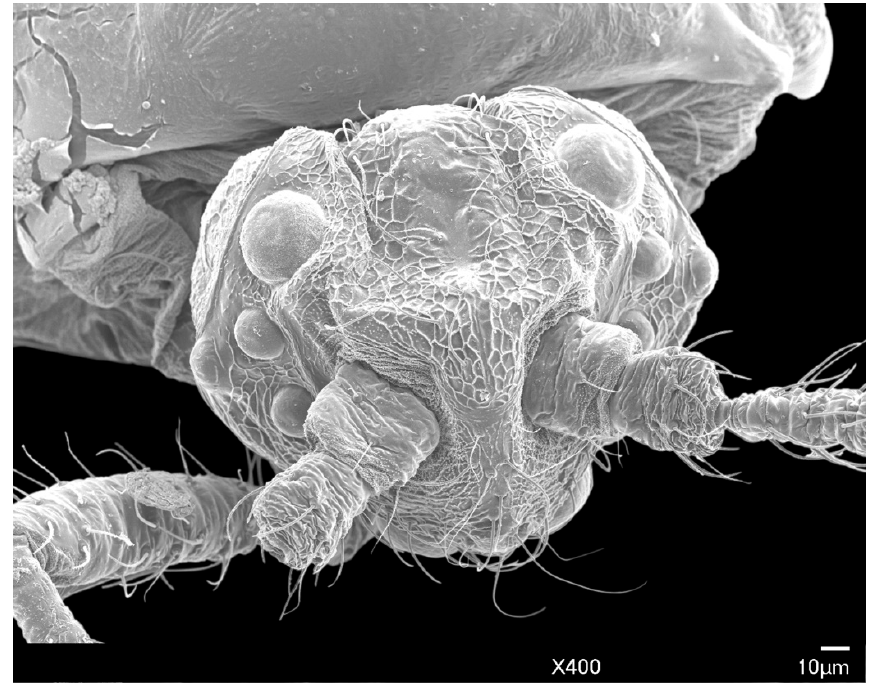
Figure 4. SEM dorso-anterior view of the male A. galliformis head, showing the post occipital ridge, post ocular ridge, ventral simple eyes, ocelli, scape, pedicel, ventral simple eyes, and genae. Antennae: The filiform, has 10 segments, with distinct scape (scp) and pedicel (pdc); the total antennal length is 500 ‒ 584 μ m (mean 529 μ m); the mean ratio of body length to antennal length is 1:1.94 μ m. The antennal segments all bear numerous long setae. The scape is 32 ‒ 55 μ m (mean 41 μ m) in length, widest at the base 38 ‒ 44 μ m (mean 41 μ m), with few setae. The pedicel is 46 ‒ 53 μ m (mean